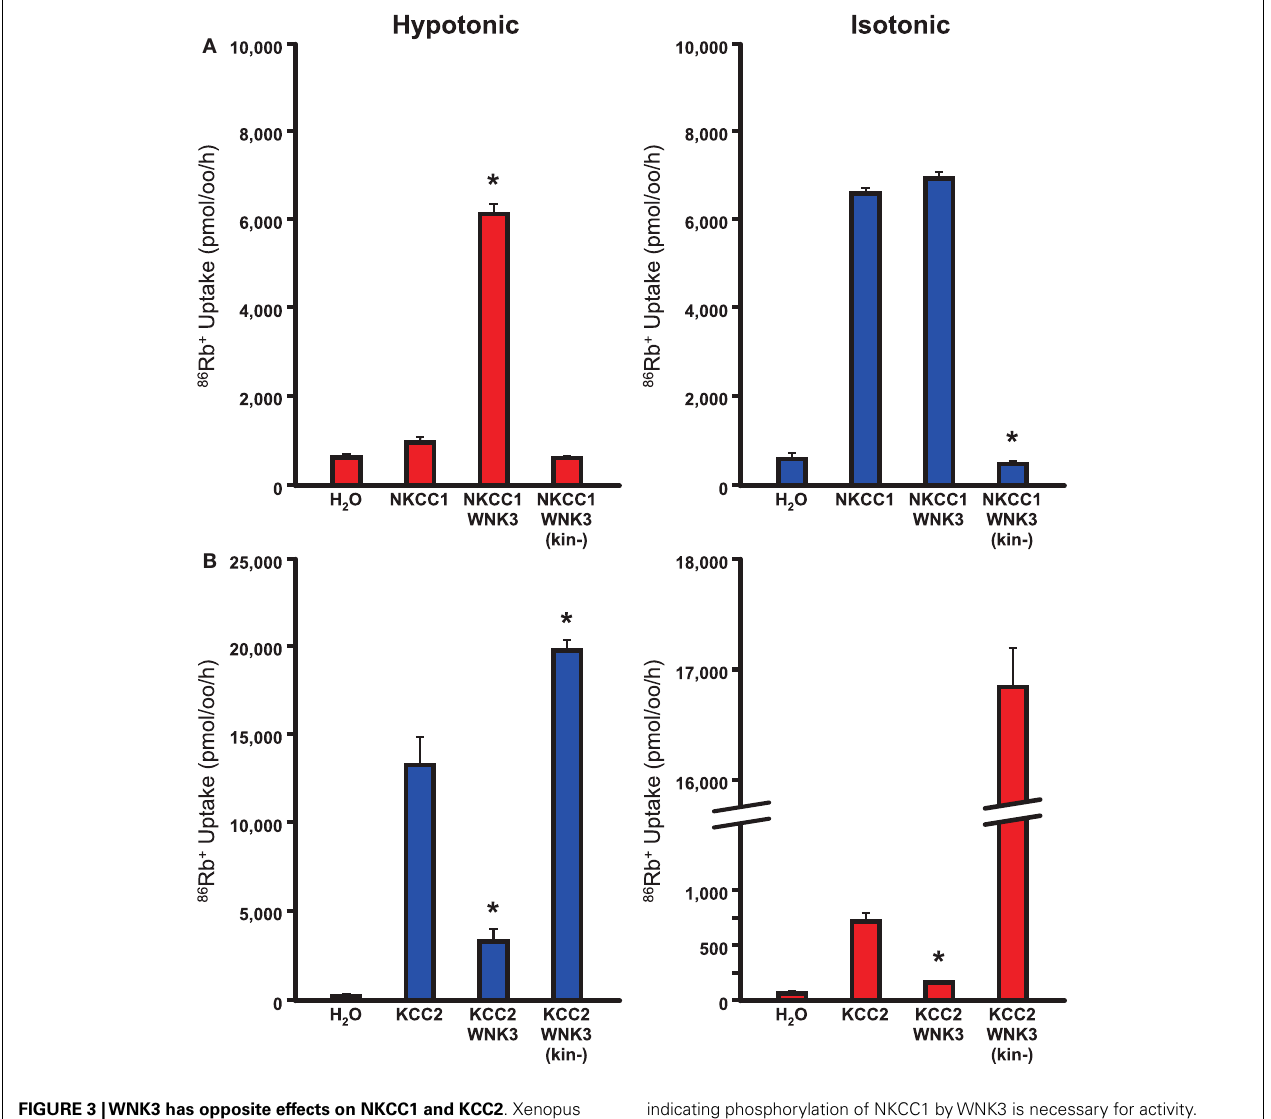
FIGURE 3 |WNK3 has opposite effects on NKCC1 and KCC2 . Xenopus oocytes were injected with cRNAs encoding NKCC1 (A) or KCC2 (B) alone and in combination with wild-type or kinase-dead mutantWNK3. 86Rb + influx through NKCC1 (A) or efflux through KCC2 (B) was determined as a measure of flux through these cation Cl-channels. (A) WNK3 activates NKCC1. NKCC1 normally shows little activity under hypotonic conditions (180mosM) and is active in isotonic conditions (200mM).WNK3 increases NKCC1 to maximal activity in both conditions. Kinase-deadWNK3 strongly inhibits NKCC1 activity,